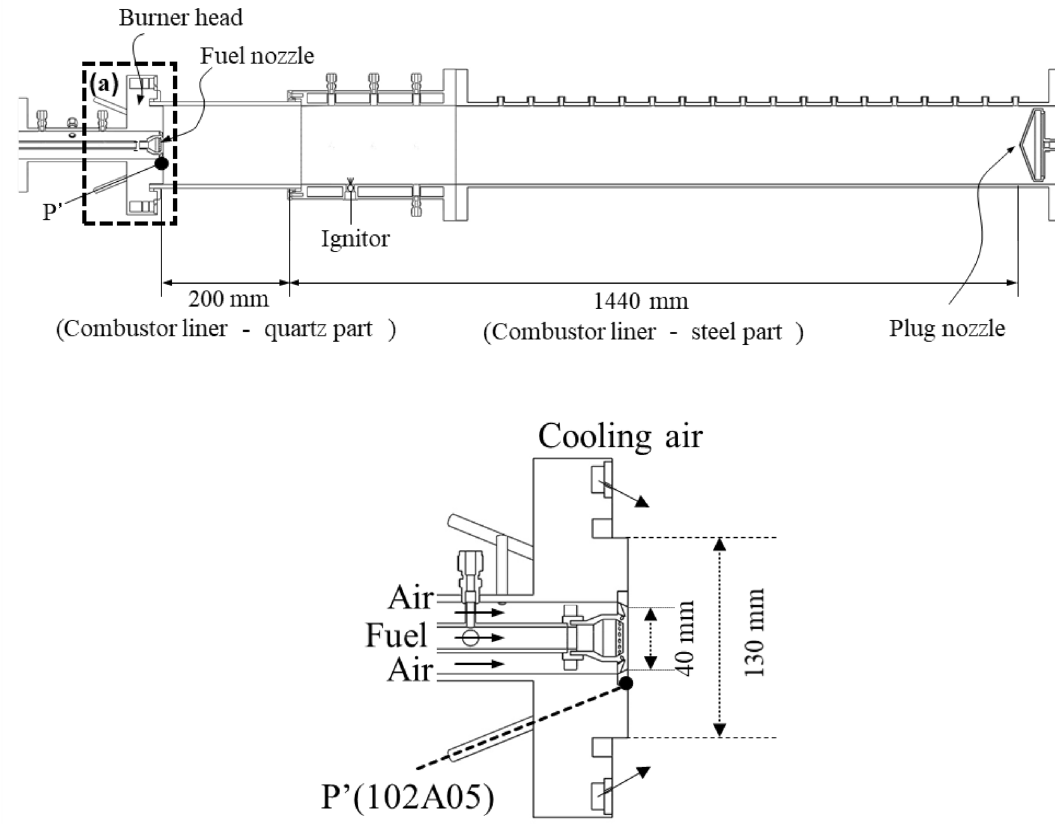
Figure 1. Schematic of the model gas turbine combustor and an enlarged view of the combustor head in